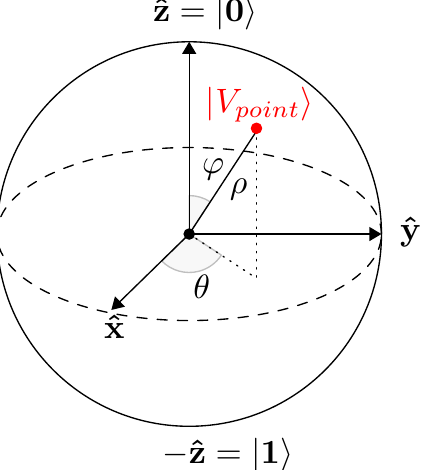
Figure 19. A viewpoint on the visibility